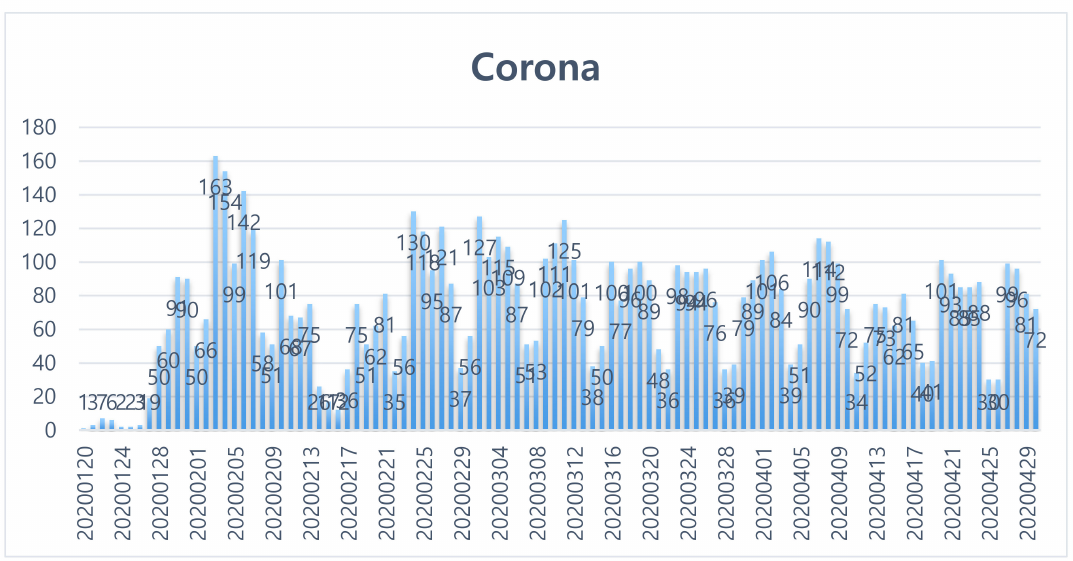
Figure 2. Media coverage trends related to “corona” (all